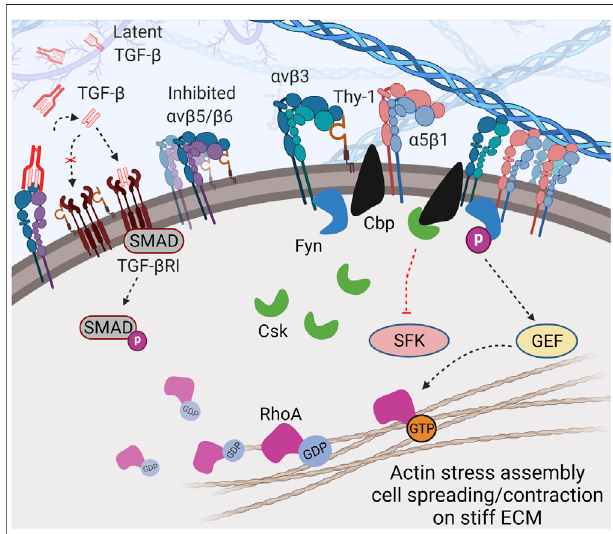
FIGURE 2 | Thy-1 modulates cell mechanosensing through direct cis - interaction. Direct cis -coupling between Thy-1 and α v integrins (especially α v β 3) further stabilizes the integrin in bent-inactive conformation and simultaneously promotes recruitmentofCbp and Fyn tothecytoplasmic tailoftheintegrin.Thisleadsto:1)balancedsignaltransductionbetween α 5 β 1 and α v integrins through competitive-cooperative binding to fi bronectin, and 2) regulated activity of SFK due to Csk recruitment by Cbp to focal adhesions and Fyn-depended RhoA activation, which promotes cell spreading and contraction in the presence of mechanical stimuli (e.g., stiff matrices). In addition, Thy-1 can inhibit TGF- β RI and likely reduce α v integrin-dependent TGF- β activation (through α v β 5, α v β 6, and α v β 8), resulting in suppression of TGF- β